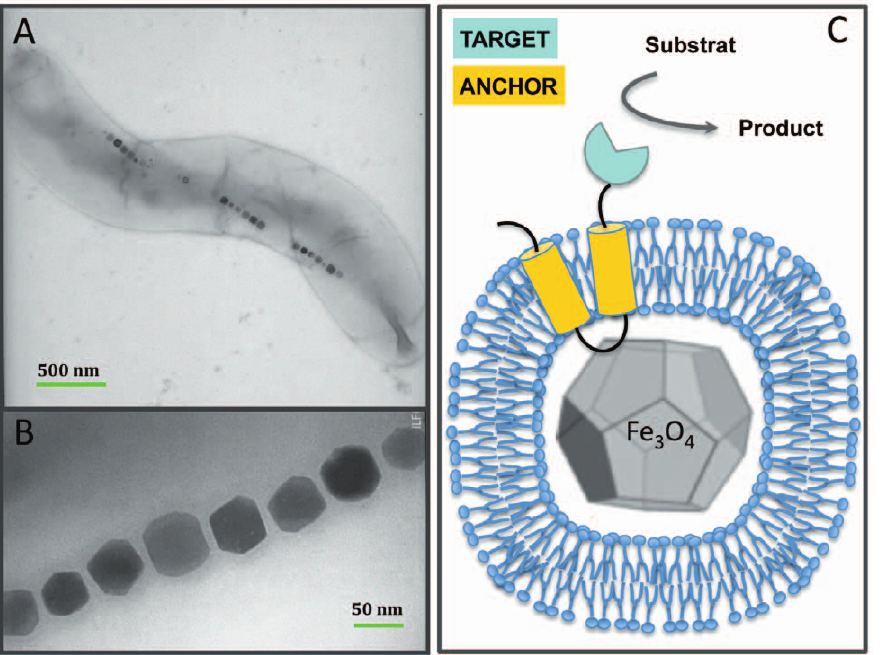
Figure 1. Functionalization of bacterial magnetosomes. ( a, b ) TEM image of magnetosomes in Magnetospirillum magneticum AMB-1 cells. The magnetite crystals are aligned within the cytoplasm of the cells on a cytoskeleton made of actin-like proteins. ( c ) Functionalization of the magnetosome membrane. The targeted enzyme (blue) is anchored on the lipid-coated magnetite crystals by fusion with a membrane protein (yellow).